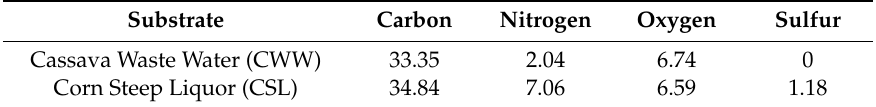
Table 1. Percentage of nitrogen, carbon, oxygen, and sulfur present in the composition of cassava waste water (CWW) and corn steep liquor (CSL).